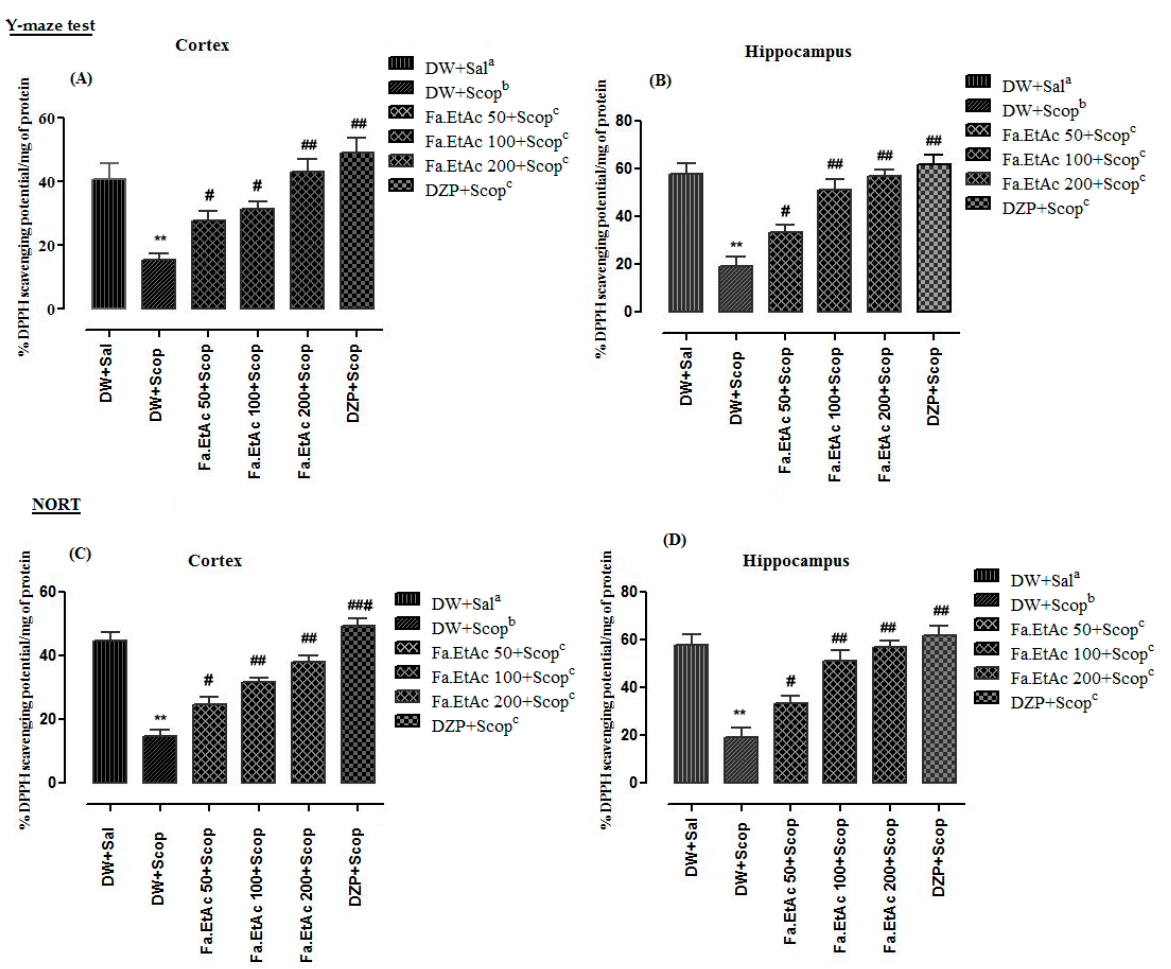
Figure 8. Ex vivo %DPPH free radical scavenging effects in ( A ) frontal cortex and ( B ) hippocampus of different animal groups in Y-maze behavioural task and ( C , D ) NORT. The data are expressed as Mean ± SEM; each value corresponds to a mean of eight animals. One-way ANOVA followed by Dunnett’s post hoc multiple comparison test to determine the values of p . ** p < 0.01; comparison of DW + Sal a (Normal control) vs. DW + Scop b (Scopolamine treated), # p < 0.05, ## p < 0.01, and ### p < 0.001; comparison of (DW + Scop) b vs. DZP + Scop c (Donepezil treated) and Fa.EtAc c (50, 100 and 200 mg/kg)-treated groups), ns: values not significantly different in comparison to (DW + Scop) b -treated group using one-way ANOVA followed by Dunnett’s post hoc multiple comparison test.